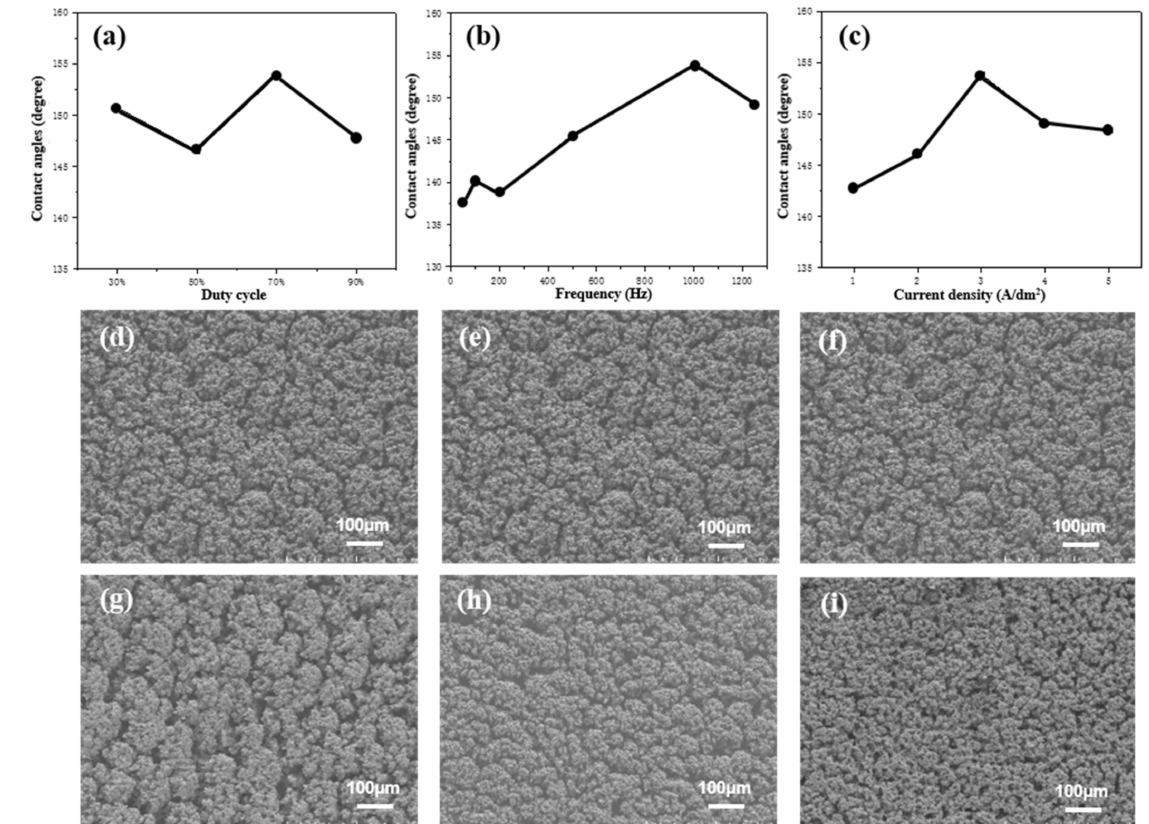
Figure 7. The WCA change trends of the Ni-Co/WS 2 nanocomposite coatings prepared under different duty cycles ( a ), frequencies ( b ), and current densities ( c ); and SEM images at a duty ratio of 70% ( d ) and 90% ( g ), frequency of 1000 Hz ( e ), and 1250 Hz ( h ), and current densities of 3 A/dm 2 ( f ) and 5 A/dm 2 ( i